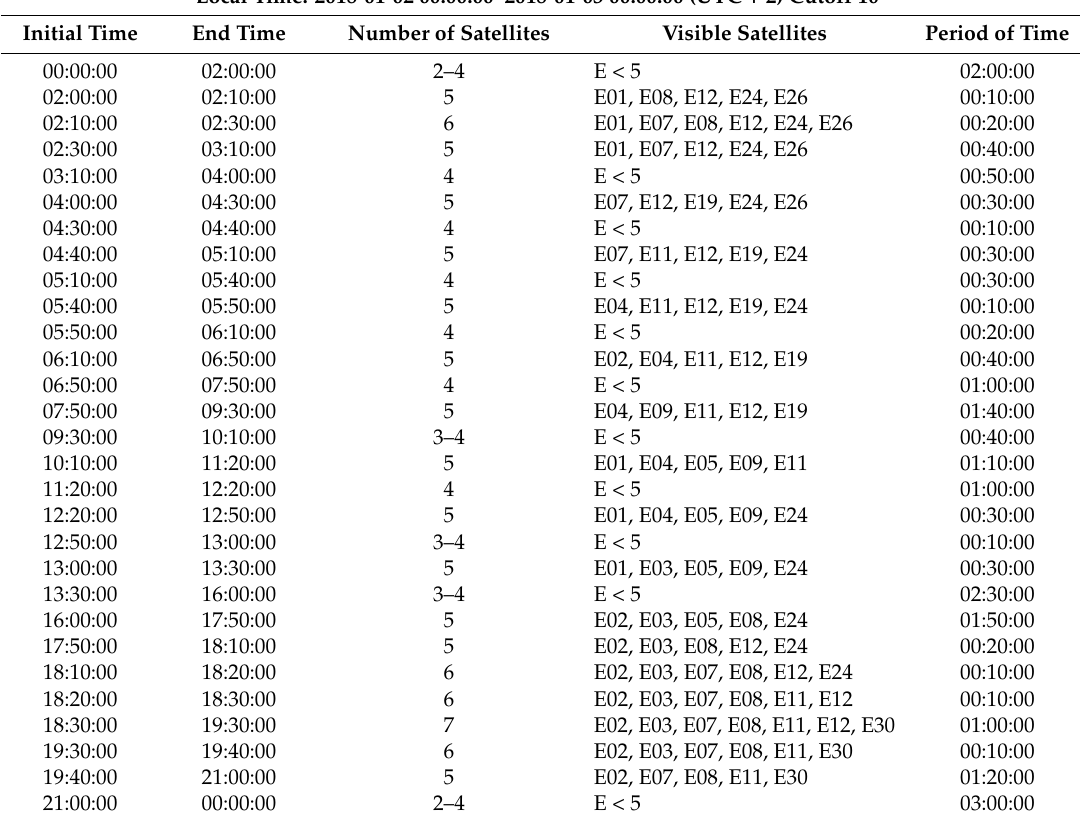
Table 6. Galileo satellites availability for the Day of Year: 002, 2018.